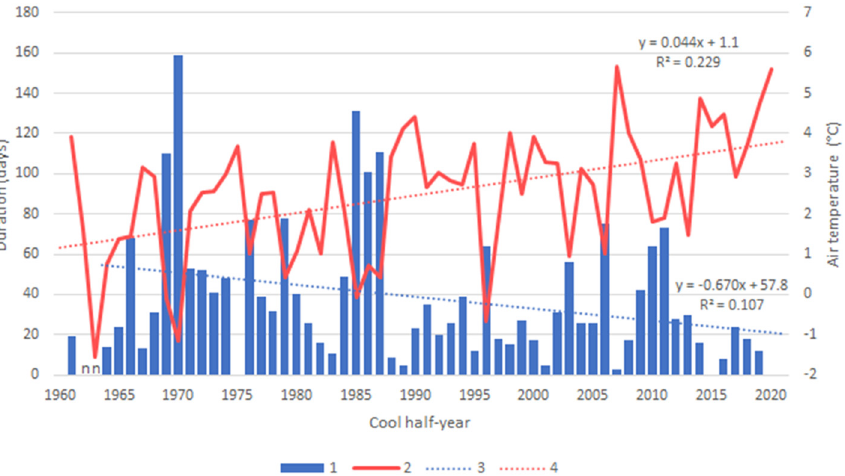
Figure 8. Changes in the duration of ice phenomena on the Warta River in Pozna ń against the backdrop of the average air temperature in the cool half-year (November to April) in 1961–2020; 1—ice phenomena, 2—average air temperature in the cool half-year, 3—linear trend of ice phenomena in 1964–2020 and 4—linear trend of the average air temperature in the cool half-year in 1961–2020; n— no data (source: data from IMWM-NRI and RWMB in Pozna ń ).